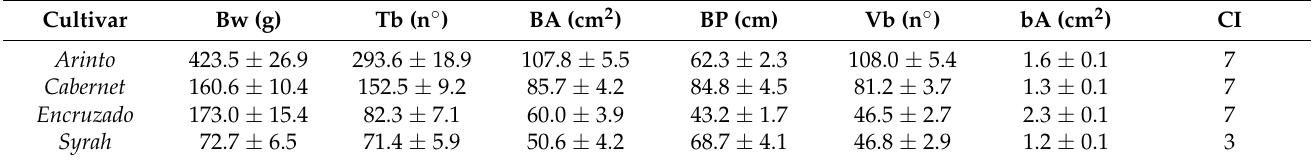
Table 2. Average ± standard error for the main variables analyzed in the full data set ( n = 48 per cultivar). Bunch compactness notations (CI) are the mode of the observations based on the OIV descriptor n ◦ 204